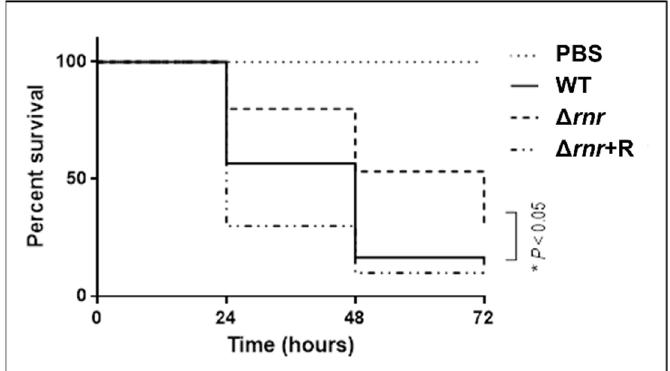
Figure 1. Survival of G. mellonella larvae after inoculation with S. pneumoniae wild type and RNase R mutant derivatives. Kaplan–Meier survival curves representing larvae infected with 5 × 10 6 bacteria/larva. Larvae were infected with S. pneumoniae wild type (WT), rnr mutant ( ∆ rnr ), ∆ rnr expressing RNase R in trans ( ∆ rnr +R), and phosphate-buffered saline (PBS) as a control for 72 h. The median survival time after infection with ∆ rnr is 72 h, whereas with the wild type is 48 h, and only 24 h after infection with ∆ rnr +R . The results represent three independent experiments.